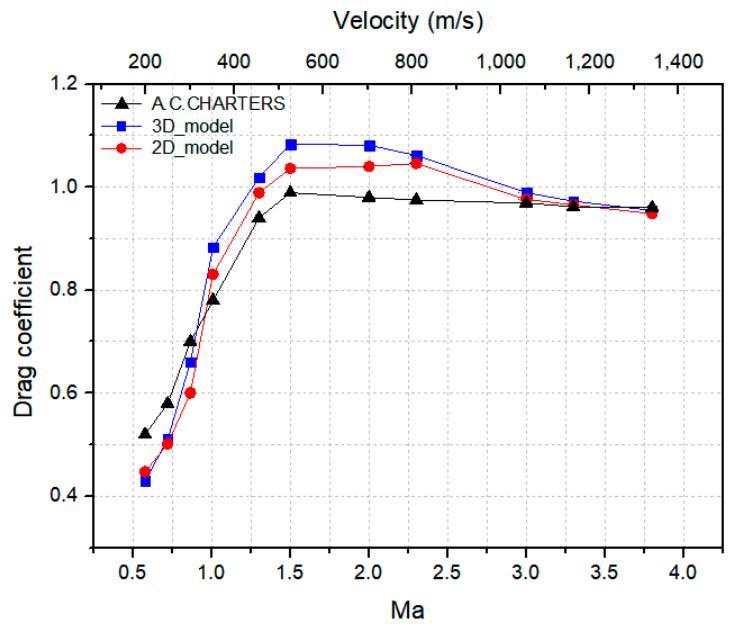
Figure 3. Validation and comparison of the drag coefficient when the sphere diameter is 14.28 mm. Verification of experimental data of Charters [32] using two-dimensional and three-dimensional CFD simulation results.